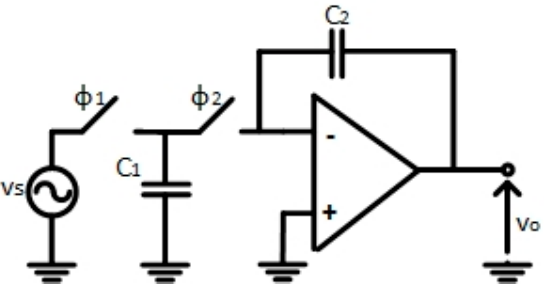
Figure 1. Conventional architecture of a closed-loop switched-capacitor integrator.